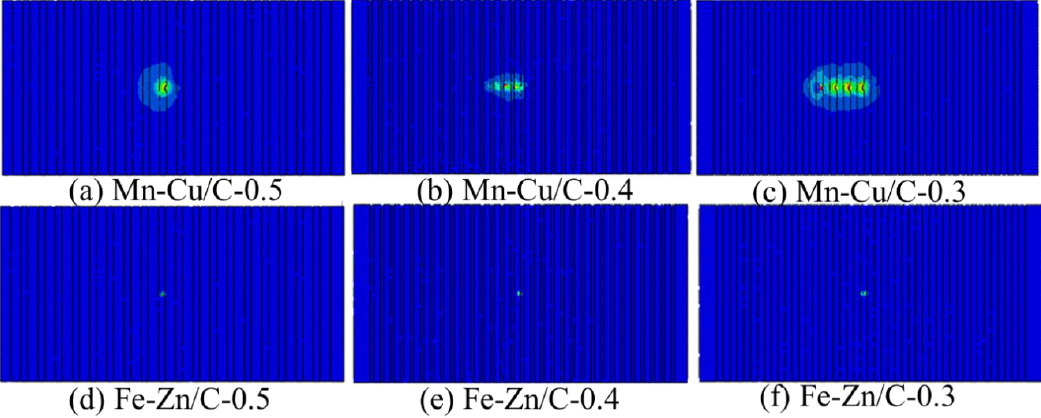
Figure 6. Friction process simulation of Mn-Cu and Fe-Zn with different weave center distance.